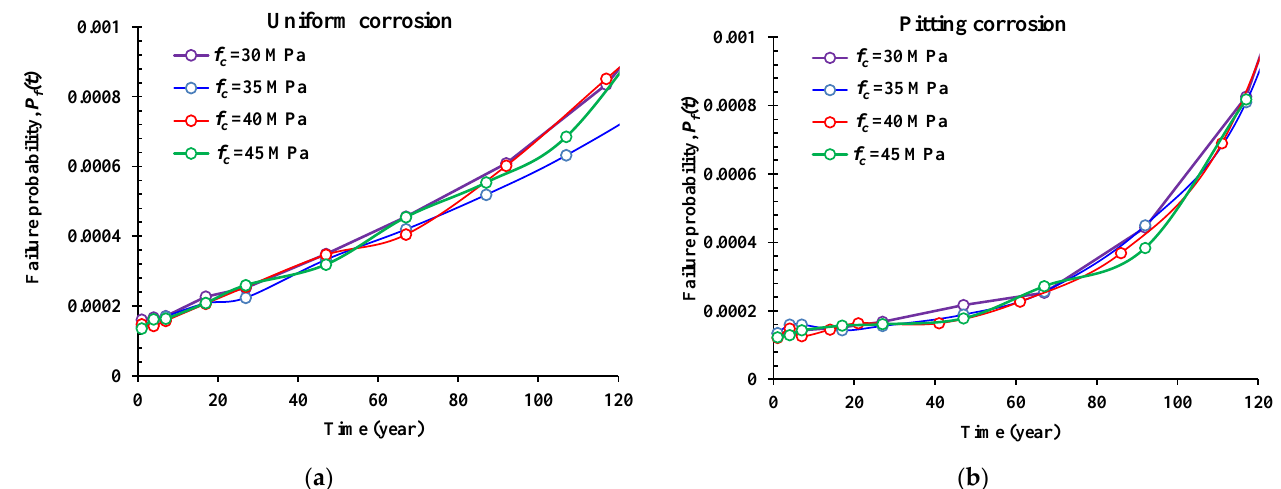
Figure 7. Influence of the concrete compressive resistance ( f c ) on the reliability results. ( a ) Uniform corrosion form, ( b ) pitting corrosion form.